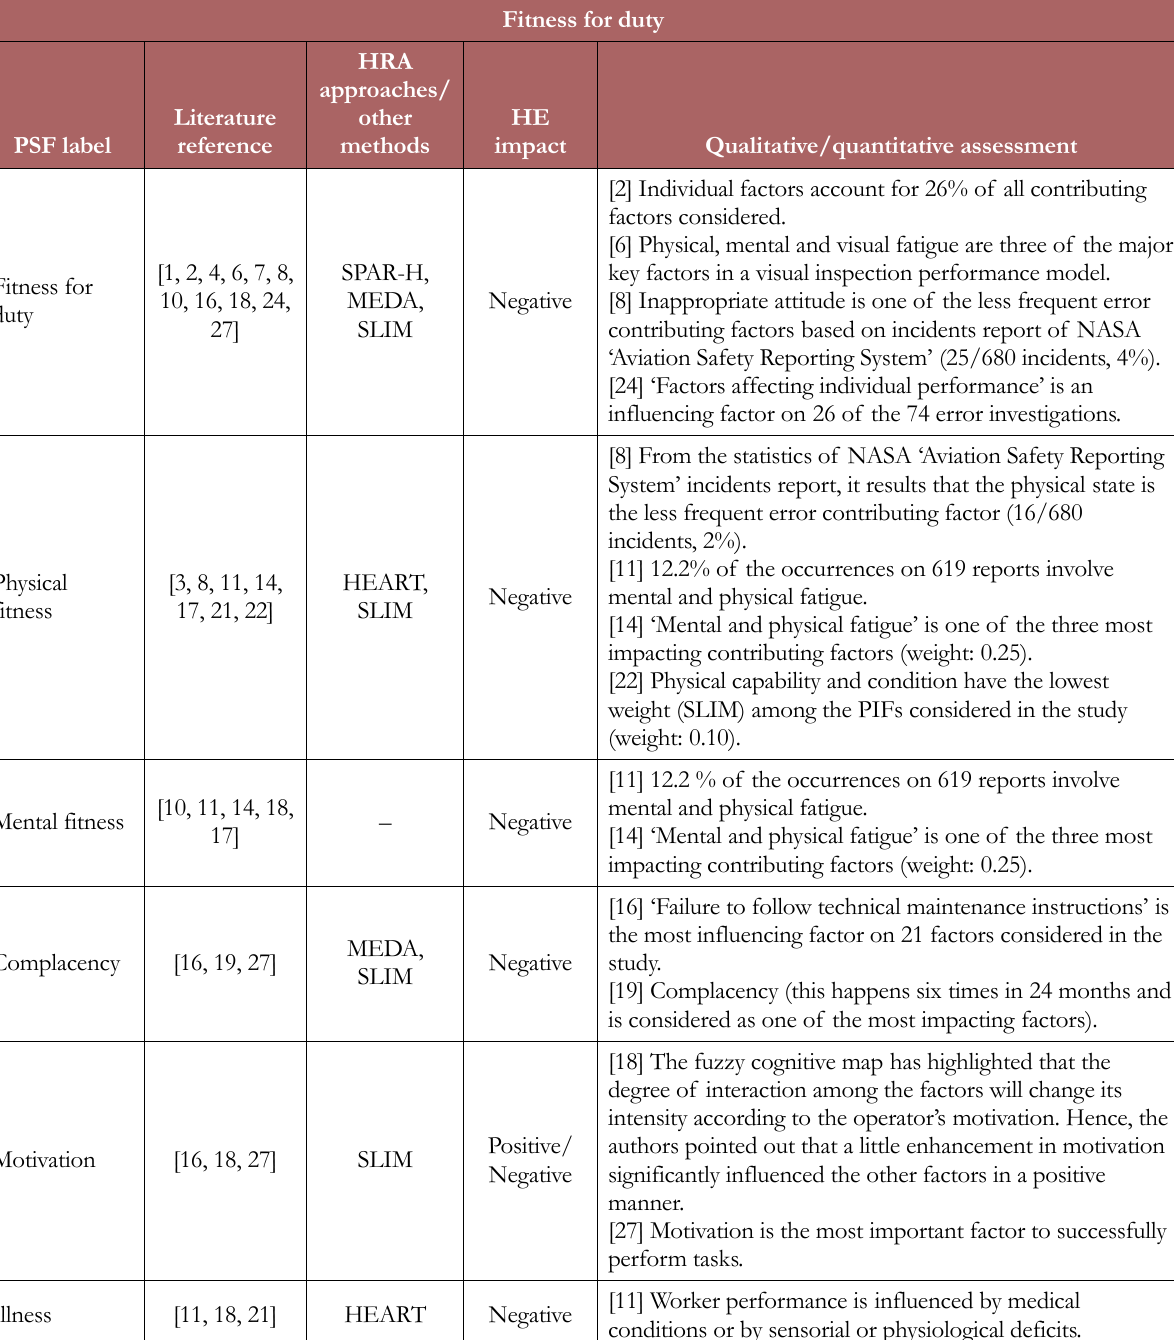
Table 7. Taxonomy of maintenance PSFs: fitness for duty